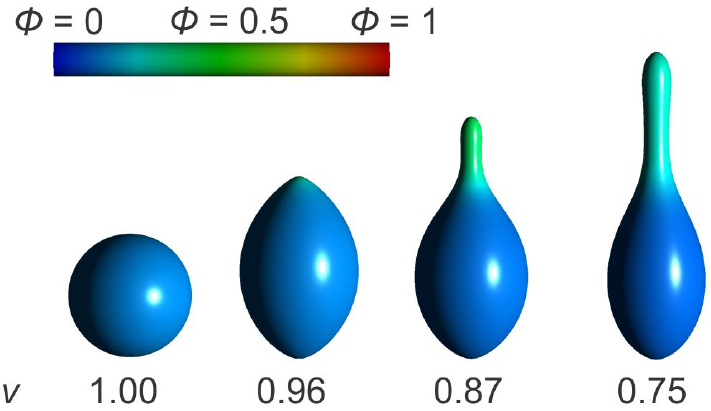
Figure 19. Equilibrium closed membrane shapes calculated for different values of the reduced volume v . The entropy of mixing was taken into account in minimization of the membrane free energy. Membrane contains two types of nanodomains denoted by A (anisotropic) and B (isotropic). Fixed value of average relative area density is φ ave = 0.15 for the nanodomains A and ( 1 − φ ave ) for the nanodomains B . The red color ( φ = 1) represents the highest possible local relative area density (concentration) of the nanodomains A , while the local concentration of the nanodomains B is given by ( 1 − φ ) . Shapes were calculated by minimizing the energy functional given by Equation (49) for the following values of model parameters: H B m = 1, D B m = 0, H A m = 8, D A m = 8, κ A = 8 κ B , κ B = 30 k B T , R 0 = 250 nm and a 0 = 100 nm 2 . Here, R 0 is the radius of the sphere with the same surface area as the surface of the investigated cell/vesicle. Adapted with permission from ref. [23]. 2017 Springer